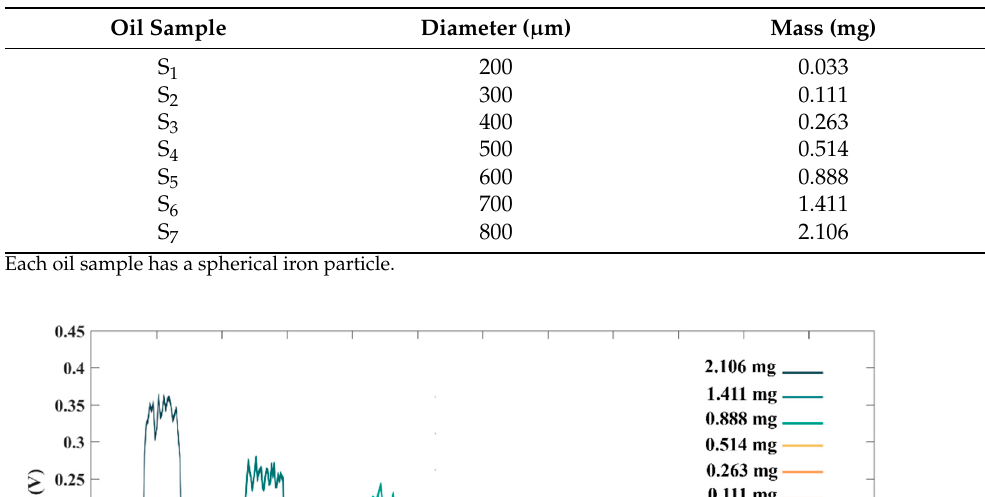
Table 2. Comparison table of particle size and mass.